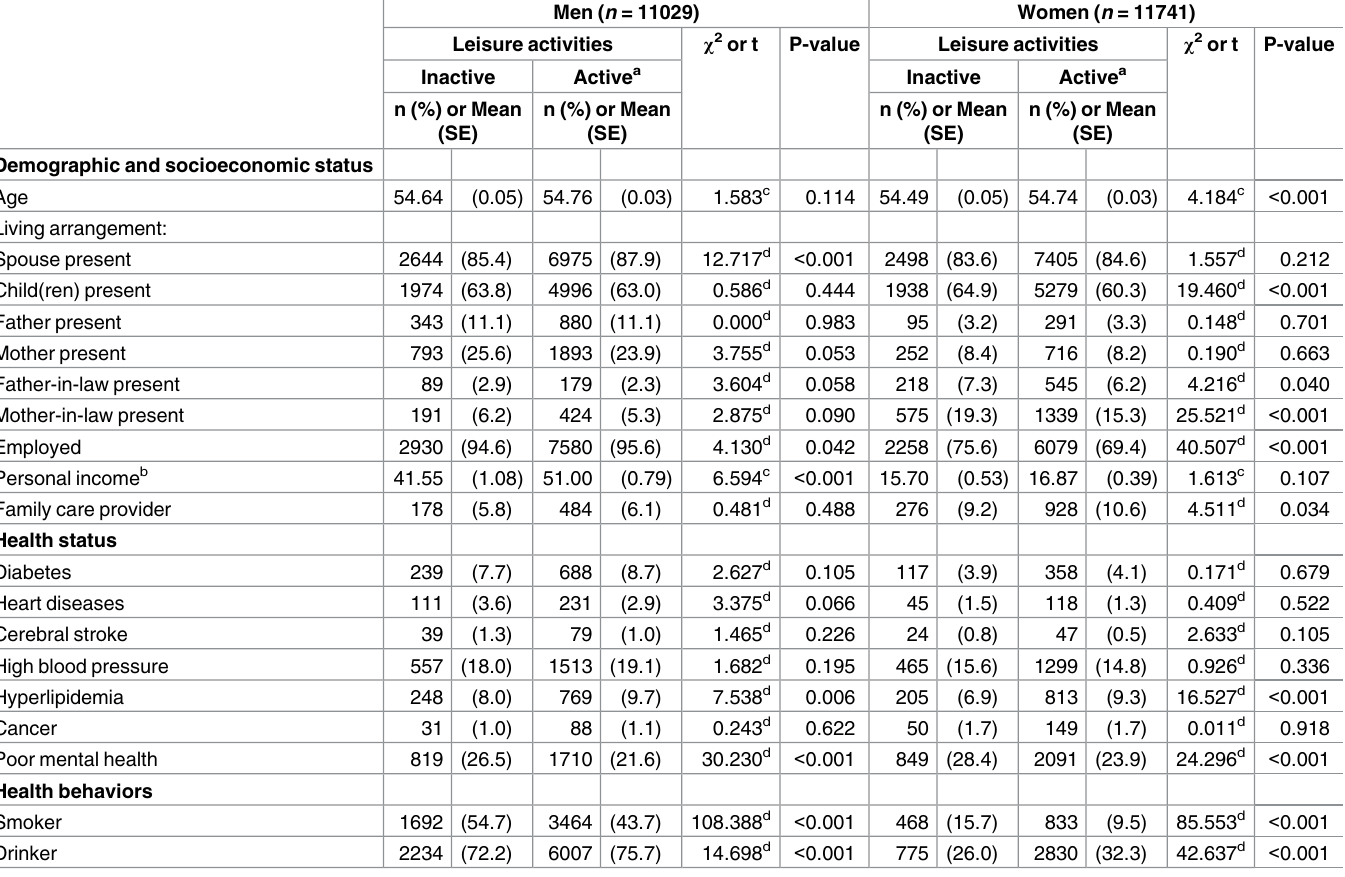
Table 3. Characteristics of active and inactive respondents with regard to leisure